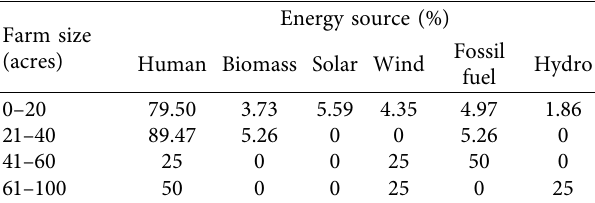
Table 2: Farm size and agricultural machinery ownership.